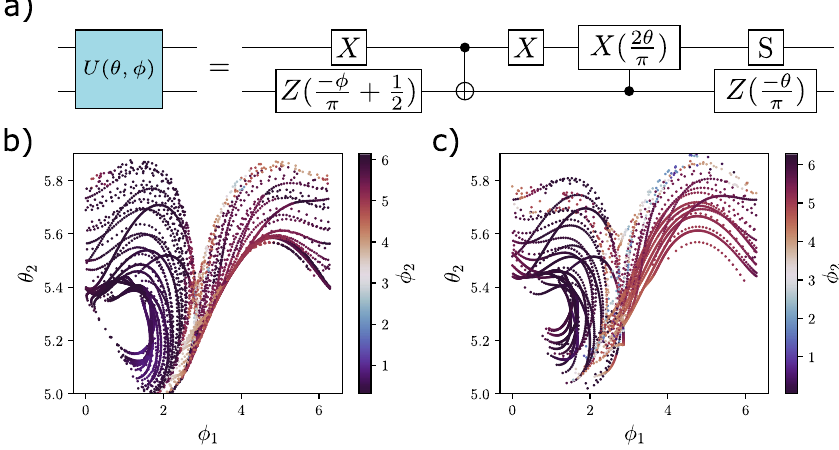
P Fig. 5 Many body scars in the PXP model. The Hamiltonian H ¼ ð 1 (cid:2) ^ σ z n Þ ^ σ x n ð 1 (cid:2) ^ σ z n Þ , fi rst posited to describe the results of quantum n (cid:2) 1 þ 1 simulations using Rydberg atoms 25 , displays a curious property known as many-body scarring 25 , whereby from certain starting states, persistent oscillations that can be described with a low bond-order MPS are found. These are amenable to study on a NISQ machine using the quantum time-dependent variational principle of Fig. 3. a A simple set of 2-site periodic states at bond order D = 2 are parametrised by circuits with just 2 parameters per site, so 4 in total. b A partial Poincare section through the plane θ 1 = 0.9 produced from a classical simulation using the matrix product state equations of motion presented in ref. 24 . Initial conditions are chosen on a constant energy surface Hh i ¼ 0 . The partial plot was produced with initial conditions along a line with spacing δ ϕ 1 = 3 × 10 − 2 , with θ 1 = 0.9 and θ 2 = 5.41. The fi nal parameter, ϕ 3 , chosen to fi x the energy. c The same Poincare map produced simulating the quantum time-dependent variational principle in Cirq. While the fi gure is blurred somewhat by integration, the main features are still